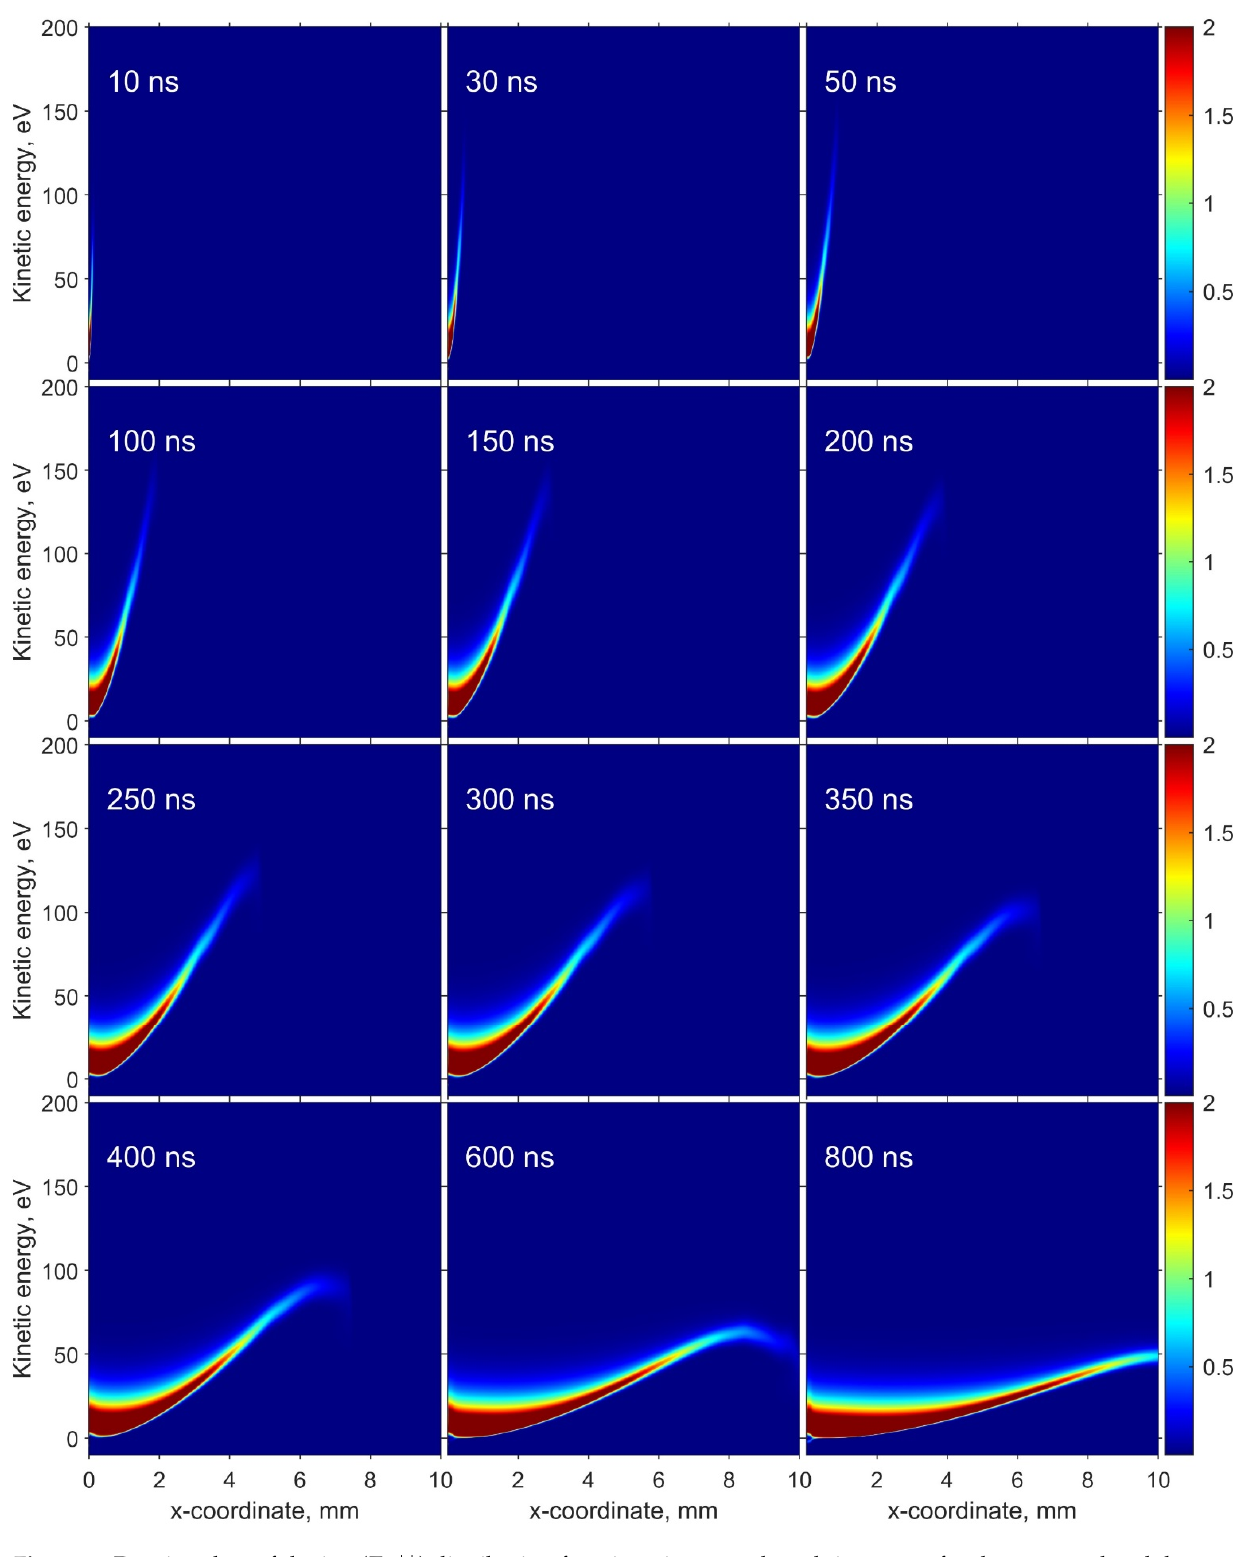
Figure 6. Density plots of the ion (Zn ++ ) distribution function given at selected time steps for the vacuum breakdown simulation in a diode with zinc cathode. The scale is linear in 10 39 s/(kg m 4 ) units. At the same time, the given density plots show the difference in the motion dynamics of ions with different charges during the plasma expansion from cathode to anode. The